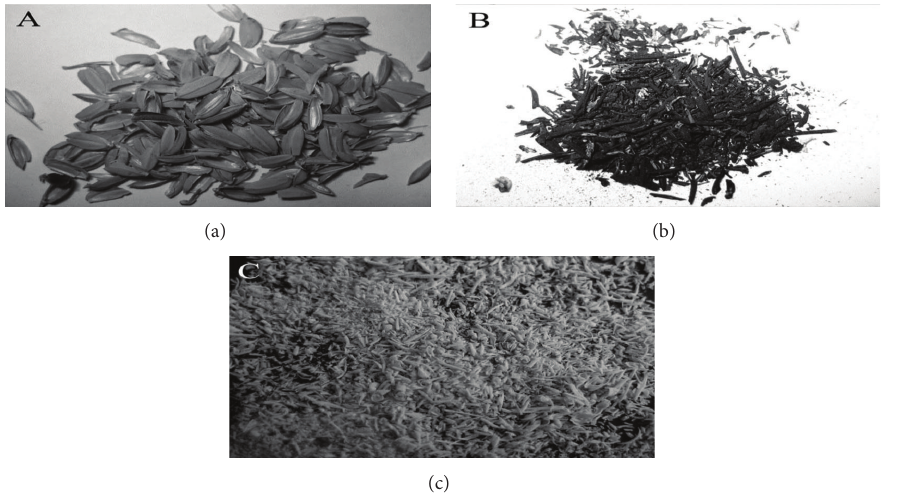
Figure 11: Typical images of (a) RH, (b) RHA, and (c) extracted silica